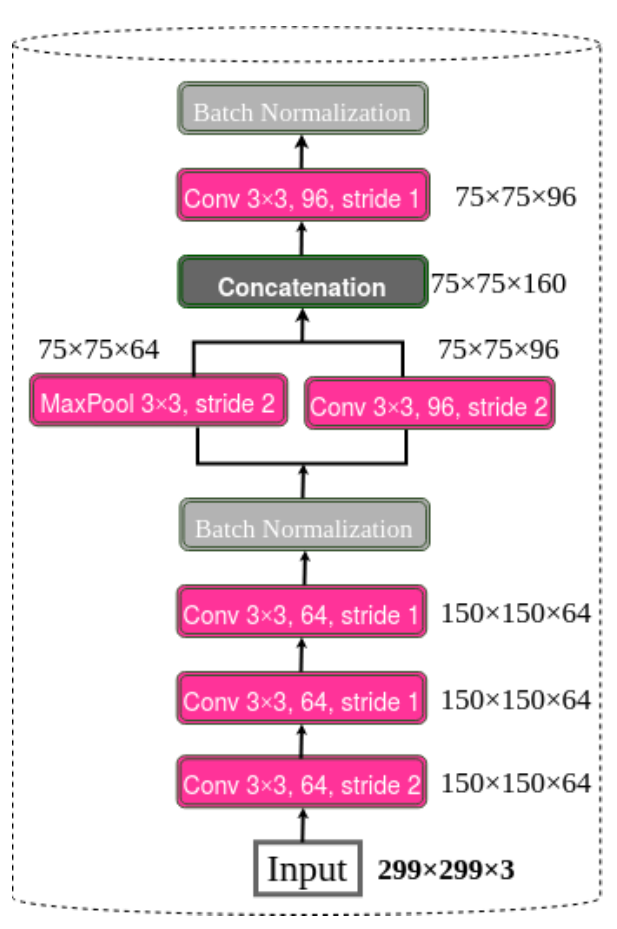
Figure 3. Structure of stem